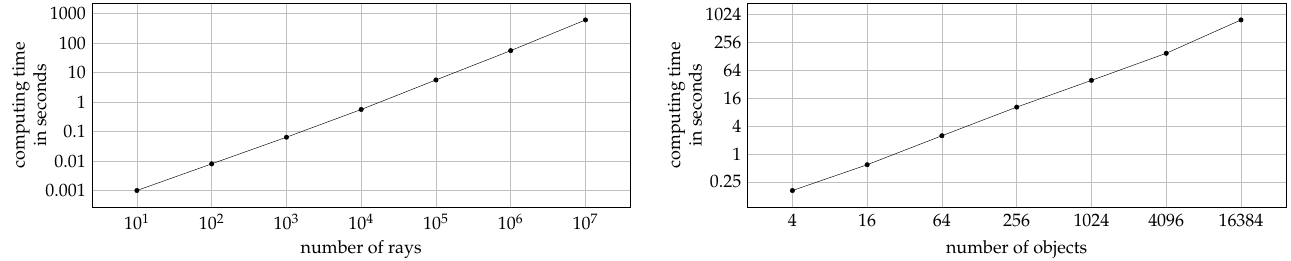
Figure 19. The diagrams show the computation time for a scene consisting of a camera and a square area as a function of the number of simulated rays ( left ) and, resp., number of objects ( right